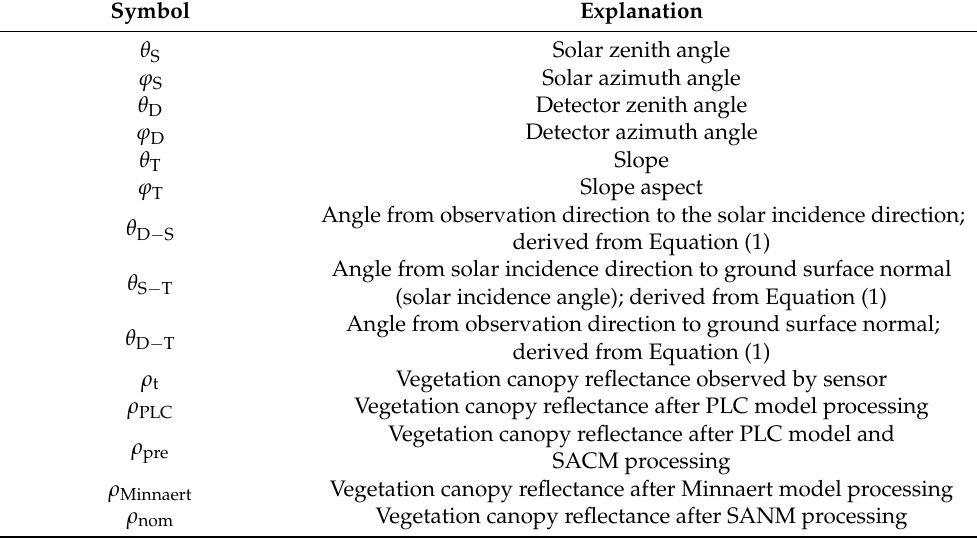
Table 1. Symbols used in the SANM.